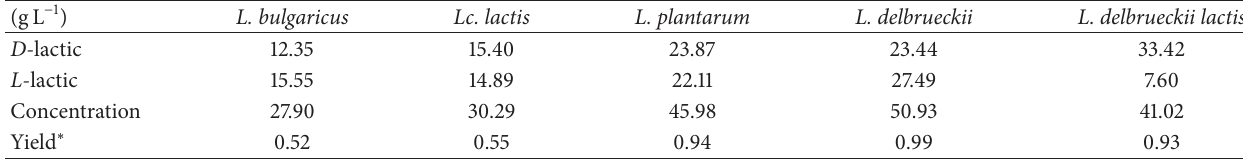
Table 2: Production of D - and L -lactic acid by bacterial strain.